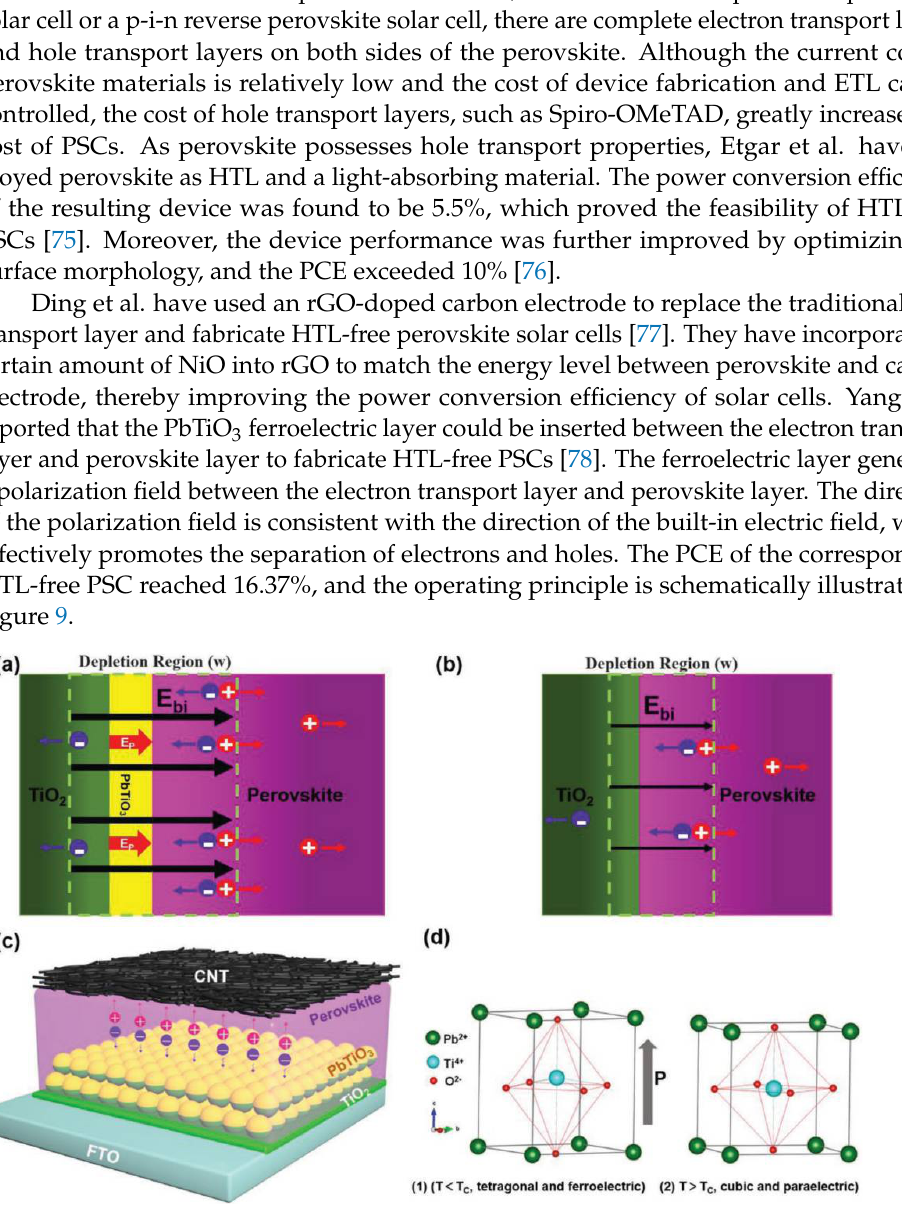
Figure 9. The schematic illustration of the ferroelectric and HTL-free PSCs, ( a , b ) The depletion region in PSCs with and without the PbTiO 3 interlayer, ( c ) Schematic structures of the ferroelectric layer-based PSC device, ( d ) Lattice structures of PbTiO 3